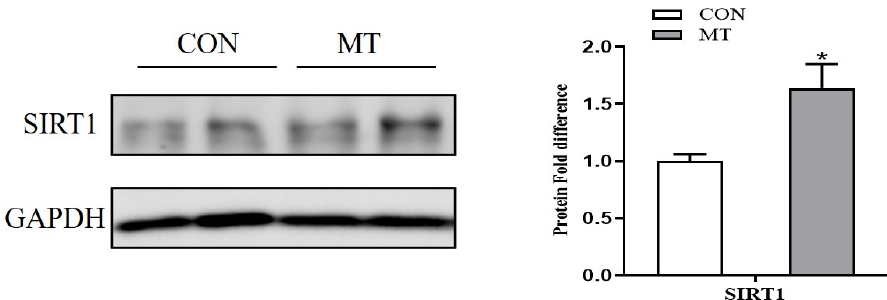
Figure 6. Effects of maternal MT supplementation during gestation on Sirt1 protein expression in placenta. Data are presented as means ± SEM, n = 6. * p < 0.05. CON = control, MT = melatonin.